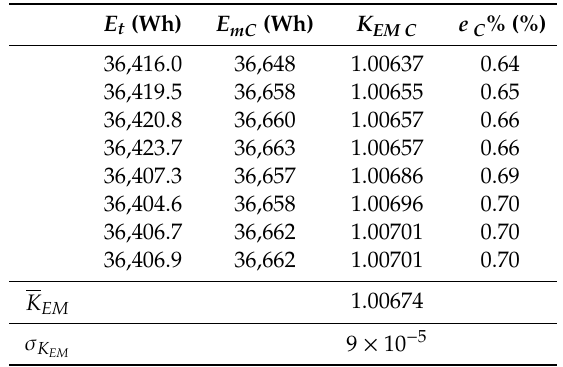
Table 4. EMUT C calibration at nominal sinusoidal conditions.